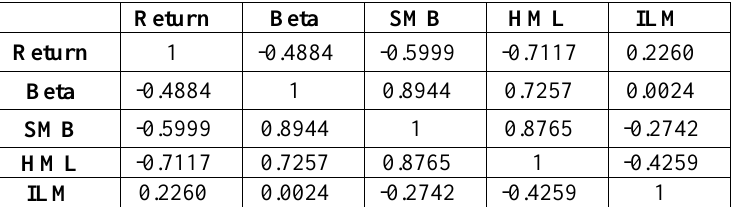
Table 3. Correlation Coefficient of Variables at the Third Level